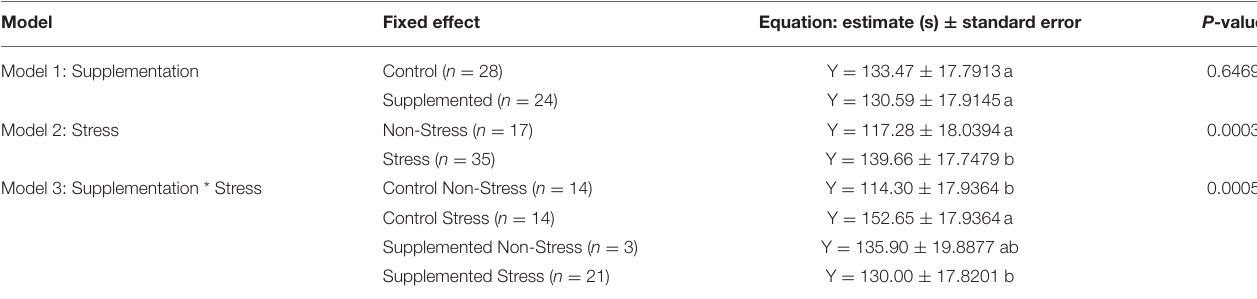
TABLE 2 | Predictive equation of the immobility duration [in seconds (Y)] spend in the Forced Swim Test (FST) based on the Lactobacillus -based supplementation and stress treatments in rodents.